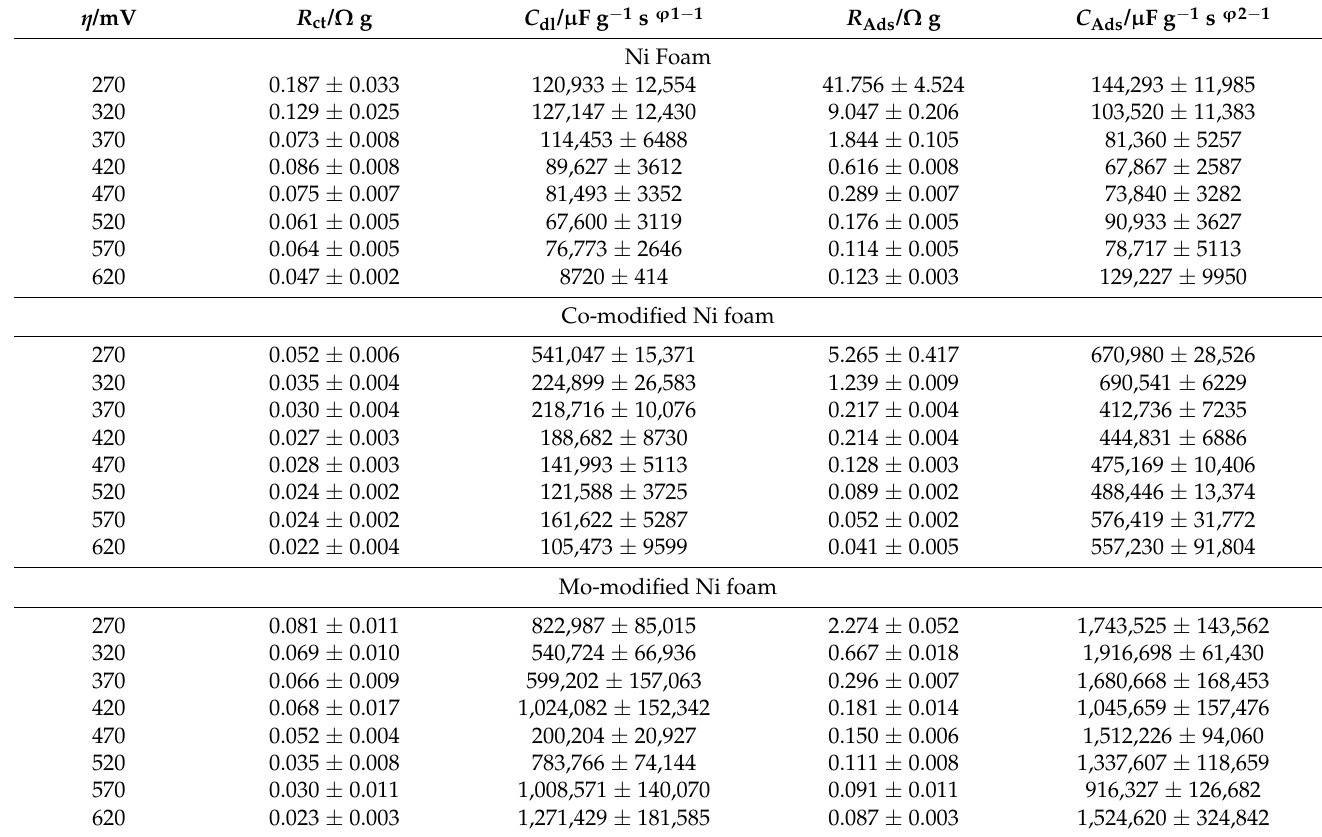
Table 2. Electrochemical parameters for the OER, obtained at as received Ni foam, Co- and Mo-modified Ni foam electrodes in contact with 0.1 M NaOH supporting solution. The results obtained here were recorded by fitting the CPE-modified Randles equivalent circuit (see Figure 5) to the experimentally obtained impedance data (reproducibility usually below 10%, χ 2 = 4.03 × 10 − 5 to 1.07 × 10 − 3